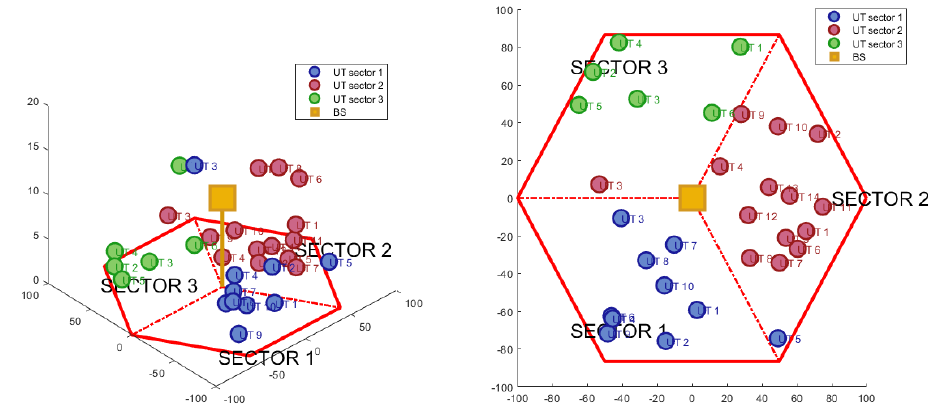
Figure 6. Cell site with 30 users after sector assignment. 3-D view on the left, 2-D top-view on the